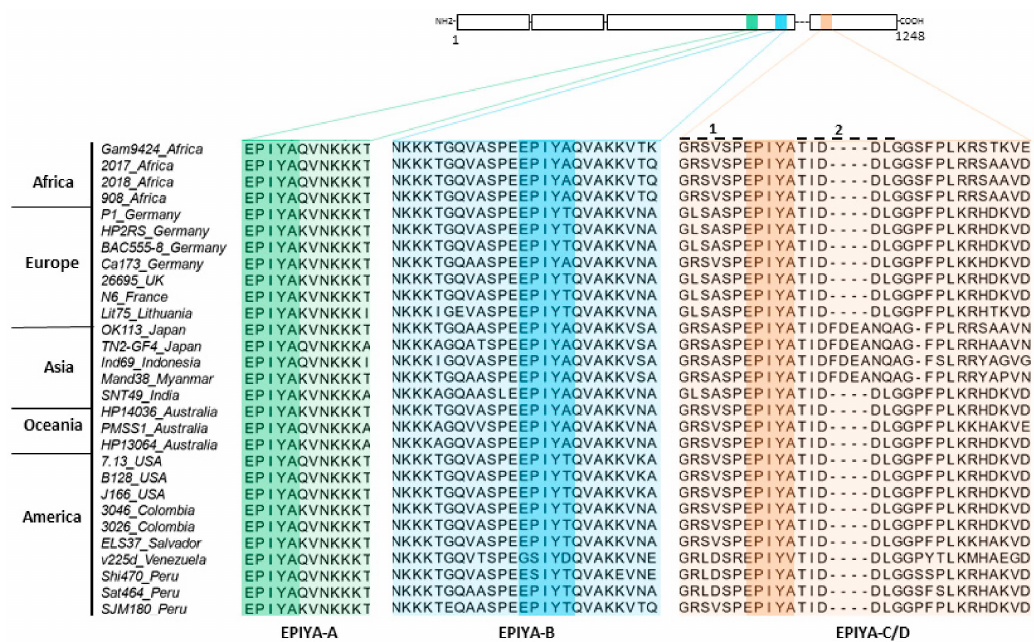
Figure 2. Sequence alignment of the EPIYA-motifs in CagA proteins from worldwide clinical H. pylori strains. Schematic representation of the CagA protein (top) and multiple alignment of a relevant segment (bottom) with color-shaded EPIYA-repeats A, B, and C / D. Variations in their flanking regions were found among clinical H. pylori isolates from di ff erent continents, as indicated above the alignment. The CagA protein sequences were downloaded from GenBank (Supplementary Table S1) and sequence alignment was done using ClustalW2 (http: // www.ebi.ac.uk / Tools / msa / clustalw2 / ). For more information see